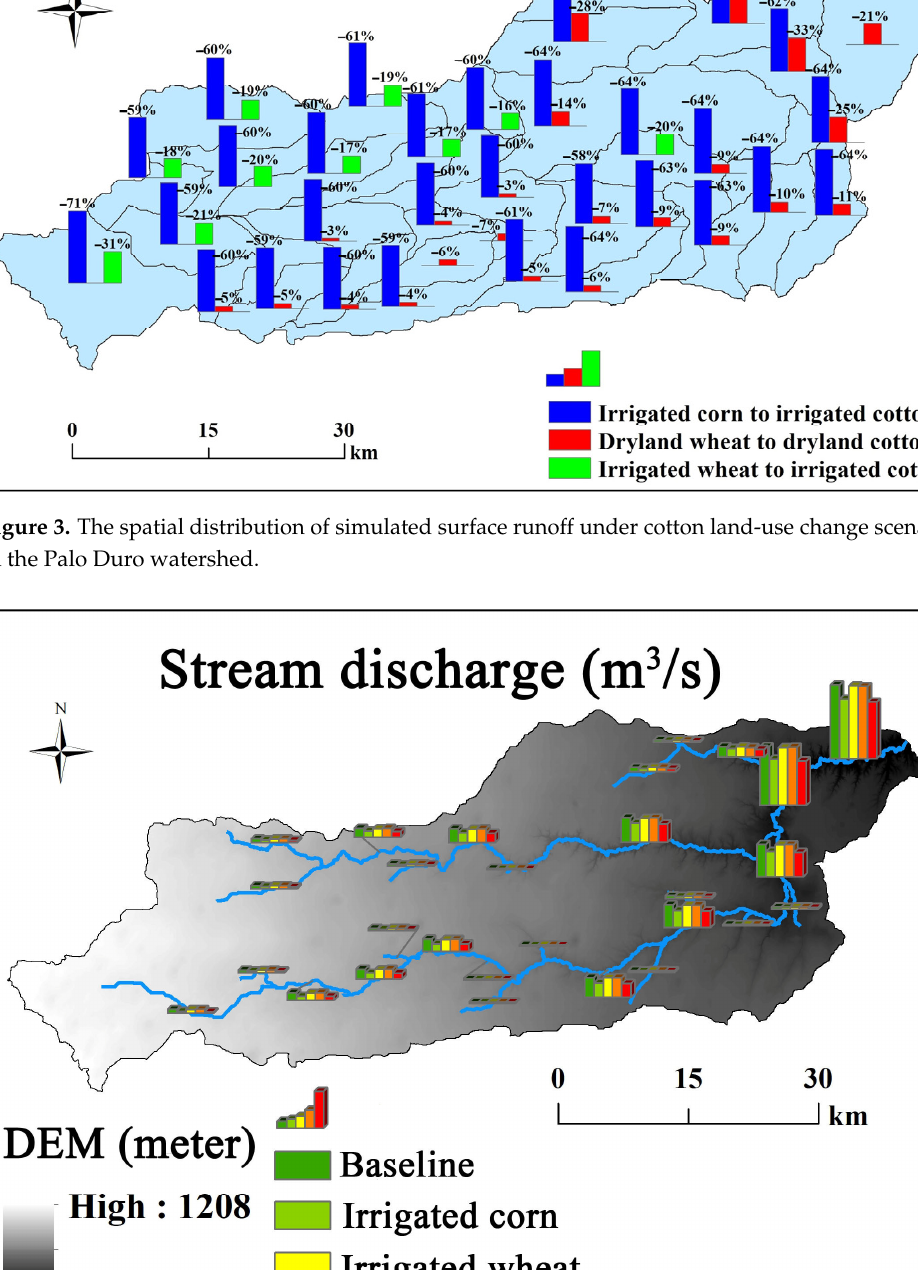
Figure 4. Comparison of stream discharge (m 3 /s) between the baseline and all land-use change scenarios in the Palo Duro watershed.